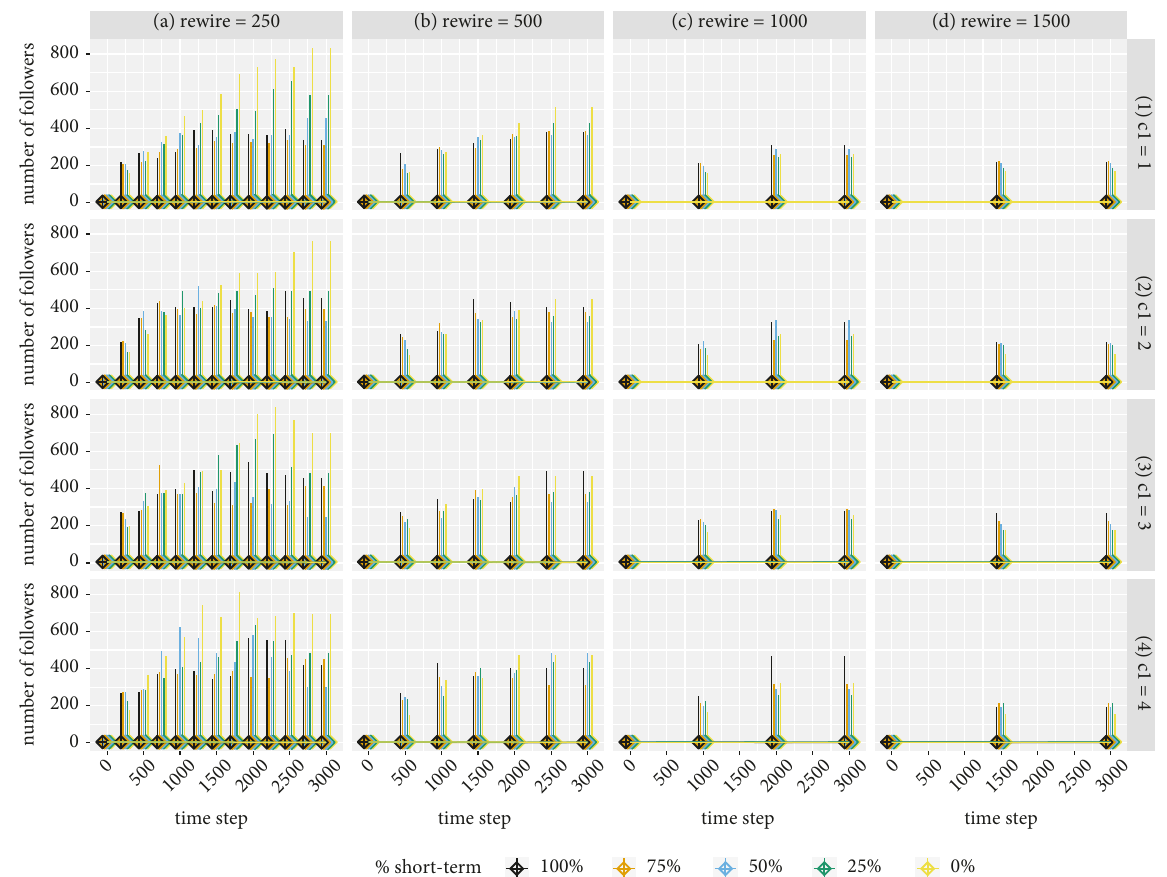
Figure 9: The dynamics for changes in the range of followers per adviser. The lines represent the range while the circles represent the median, noting that the data collection occurs after each rewiring